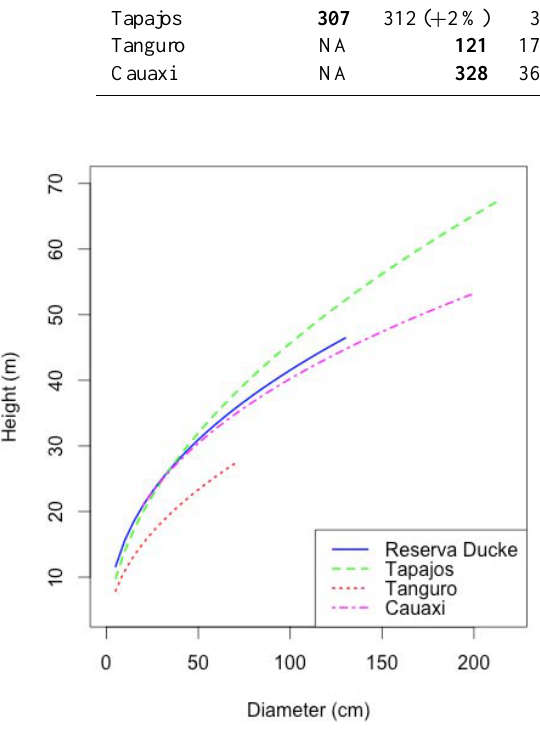
Fig. 6. Comparison of site-specific diameter–height allometries for the four study